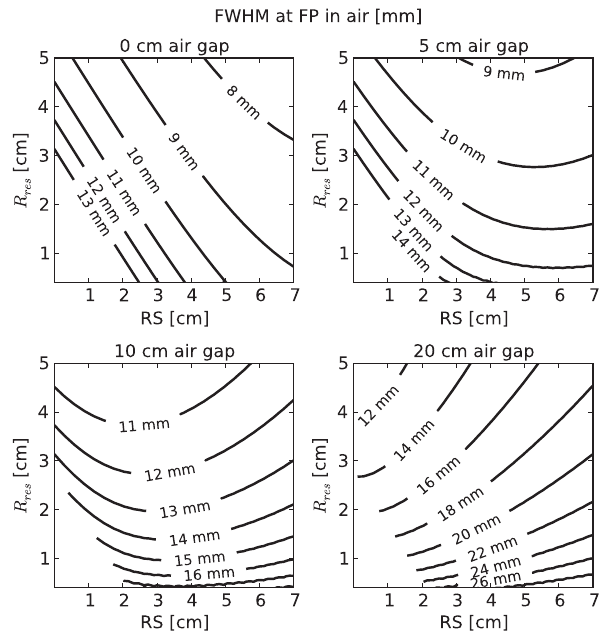
FIG. 14. FWHM (vertical) at focal point, in air, of a proton beam for four different air gaps: 0, 5, 10, and 20 cm, Nozzle 3. The horizontal axis is the thickness of the PMMA range shifter, the vertical axis the residual beam range in water as the beam passes through the focal